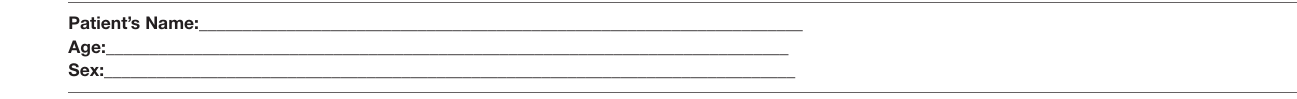
TABLE 4 | Relevant risk factors concerning DM patients before beginning